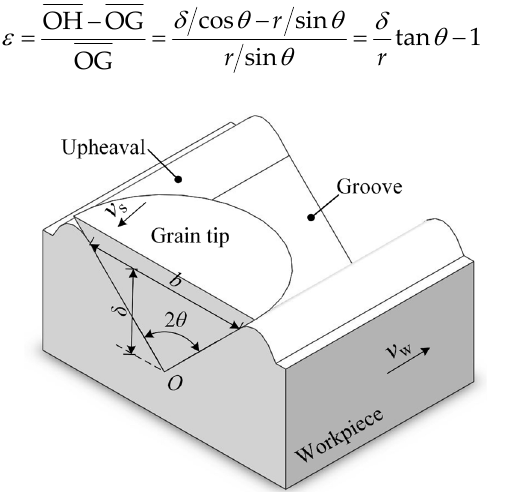
Fig. 1 Schematic diagram of the single grain grinding